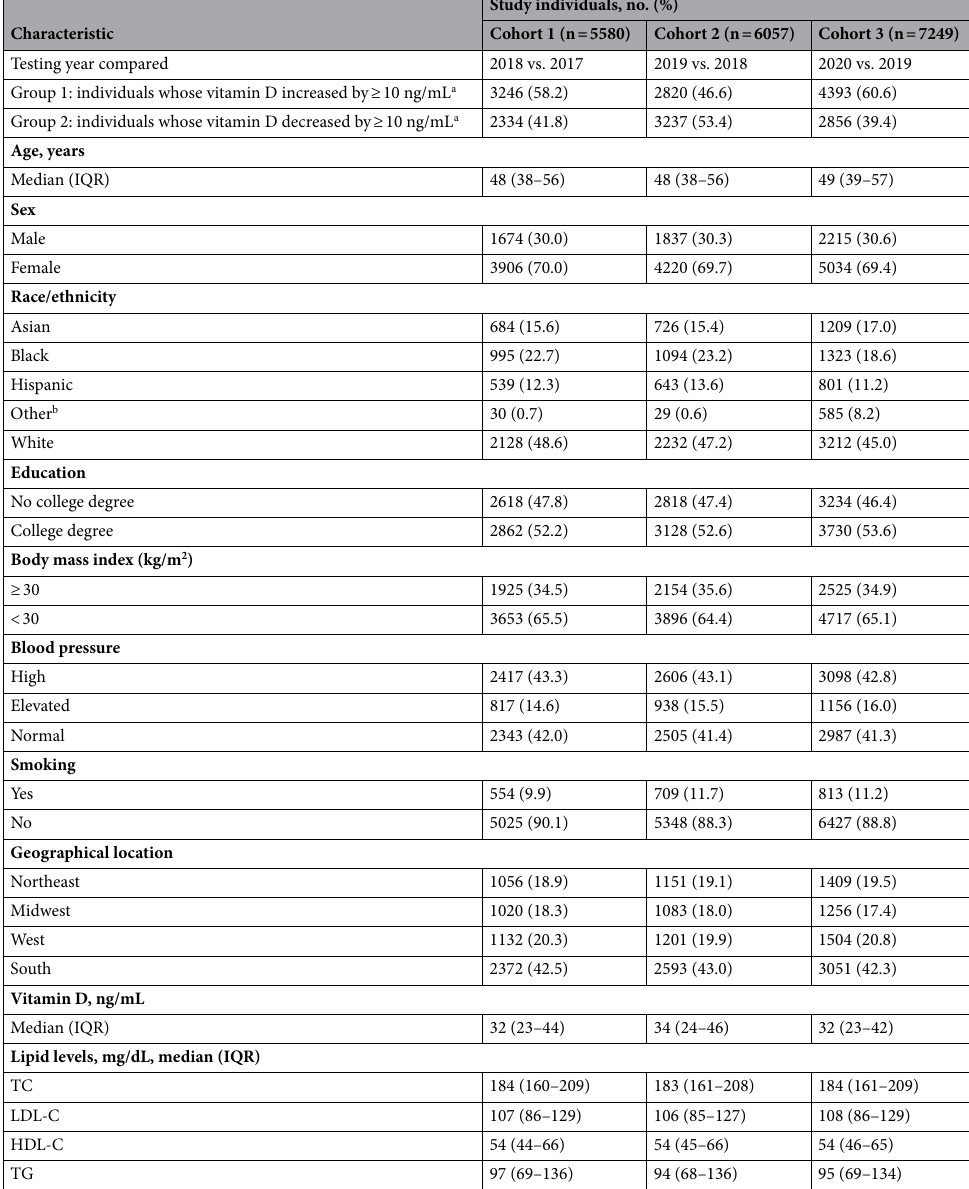
Table 1. Baseline characteristics of study cohorts. IQR: interquartile range; TC: total cholesterol; LDL-C: low- density lipoprotein cholesterol; HDL-C: high-density lipoprotein cholesterol; TG: triglycerides. a Comparisons of baseline characteristics between these two groups are reported in Tables S1, S2 and S3. b American Indian or Alaska Native, Native Hawaiian or other Pacific Islander, or 2 or more